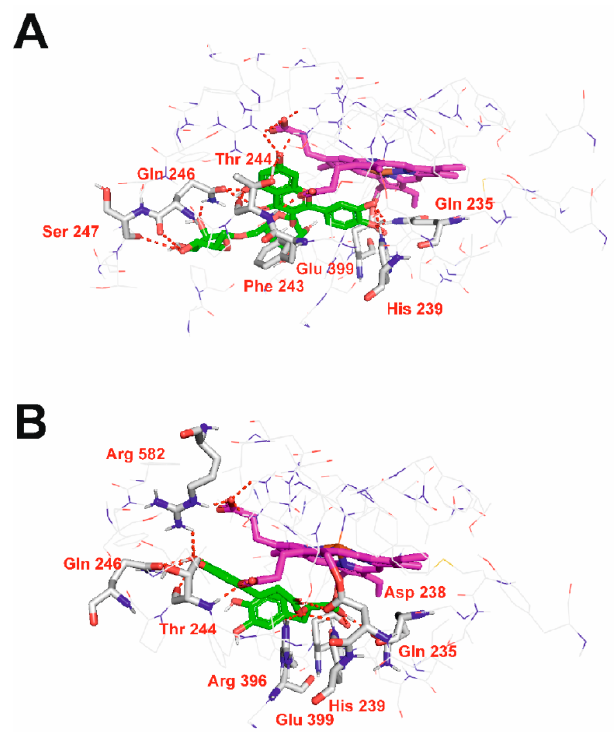
Figure 2. 3D view of rutin ( A ) and rosmarinic acid ( B ) in the catalytic site of TPO. Inhibitor molecules shown as sticks with green carbon atoms. Heme shown as sticks with magenta carbon atoms. Protein presented in wire representation with grey carbon atoms. Most important residues shown as sticks. Hydrogen bonds depicted as red dashed lines. Non-polar hydrogen atoms omitted for clarity.